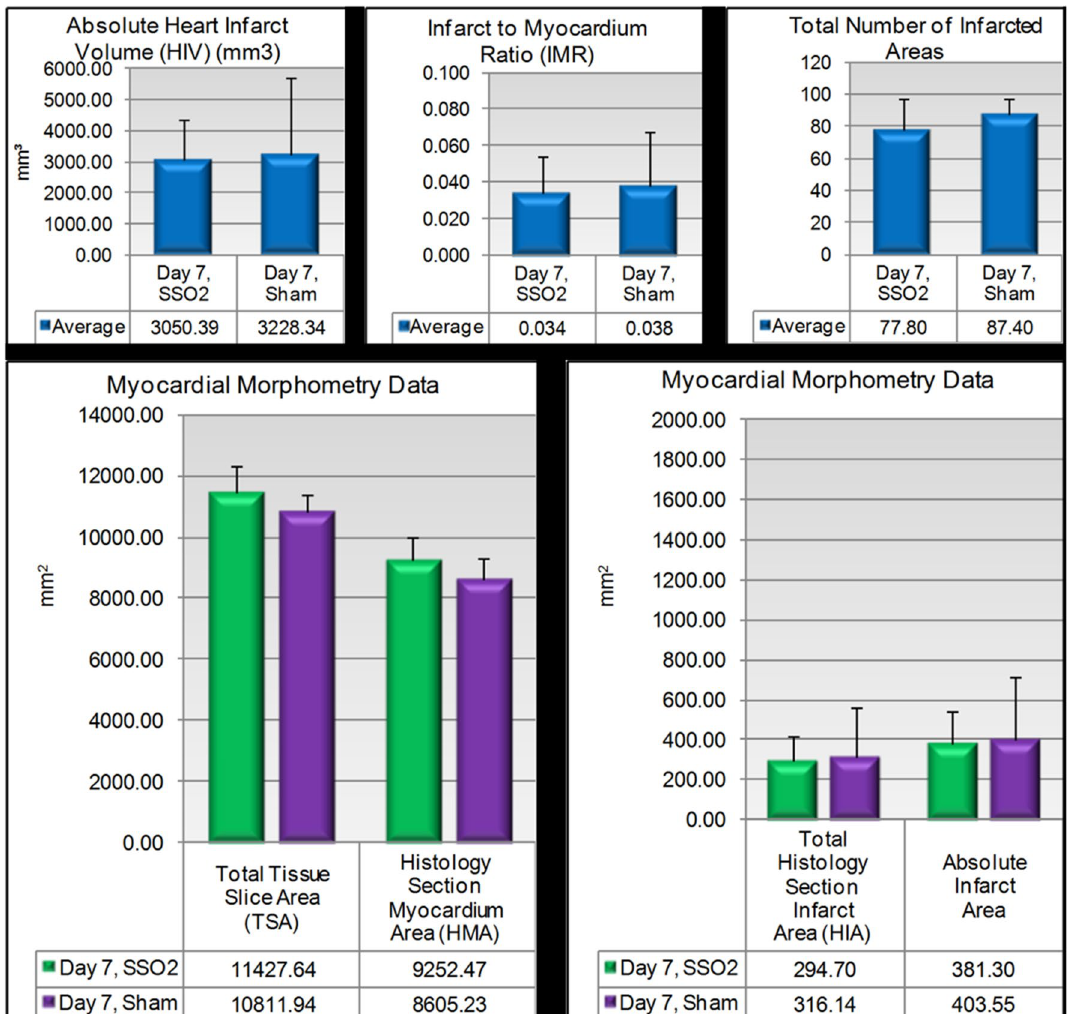
Figure 3. Key myocardial morphometric indices at 7 days. No early differences in histomorphometric indices of myocardial infarction injury can be observed hearts subjected to the SSO 2 therapy in comparison to